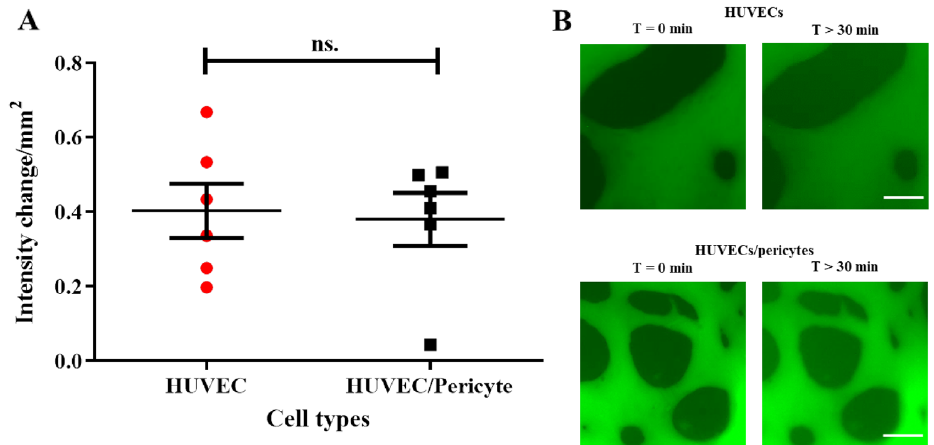
Figure 4. The impact of pericytes on vessel permeability. 70 kDa FITC-dextran was perfused after 10 days of culture. ( A ) Using ‘net-fold intensity change/mm 2 to define vessel permeability, the addition of pericytes had no significant impact on endothelial barrier function (mean ± SEM, 0.38 ± 0.07 compared with 0.4 ± 0.07 for endothelial monocultures). ( B ) Representative epifluorescence images at T = 0 and T = 30 min. Scale bar: 100 µm. N = 6; n.s., non significant.